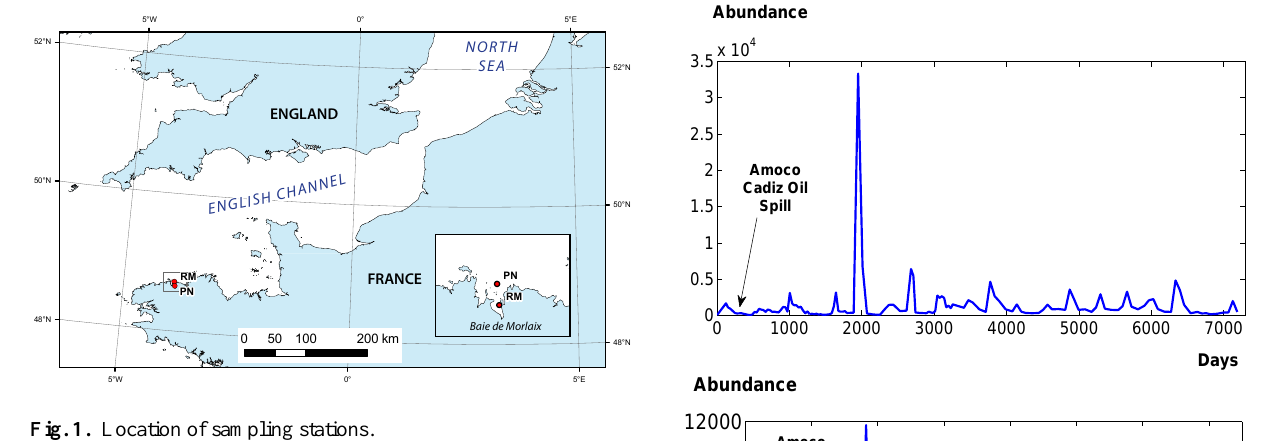
Fig. 1. Location of sampling stations.